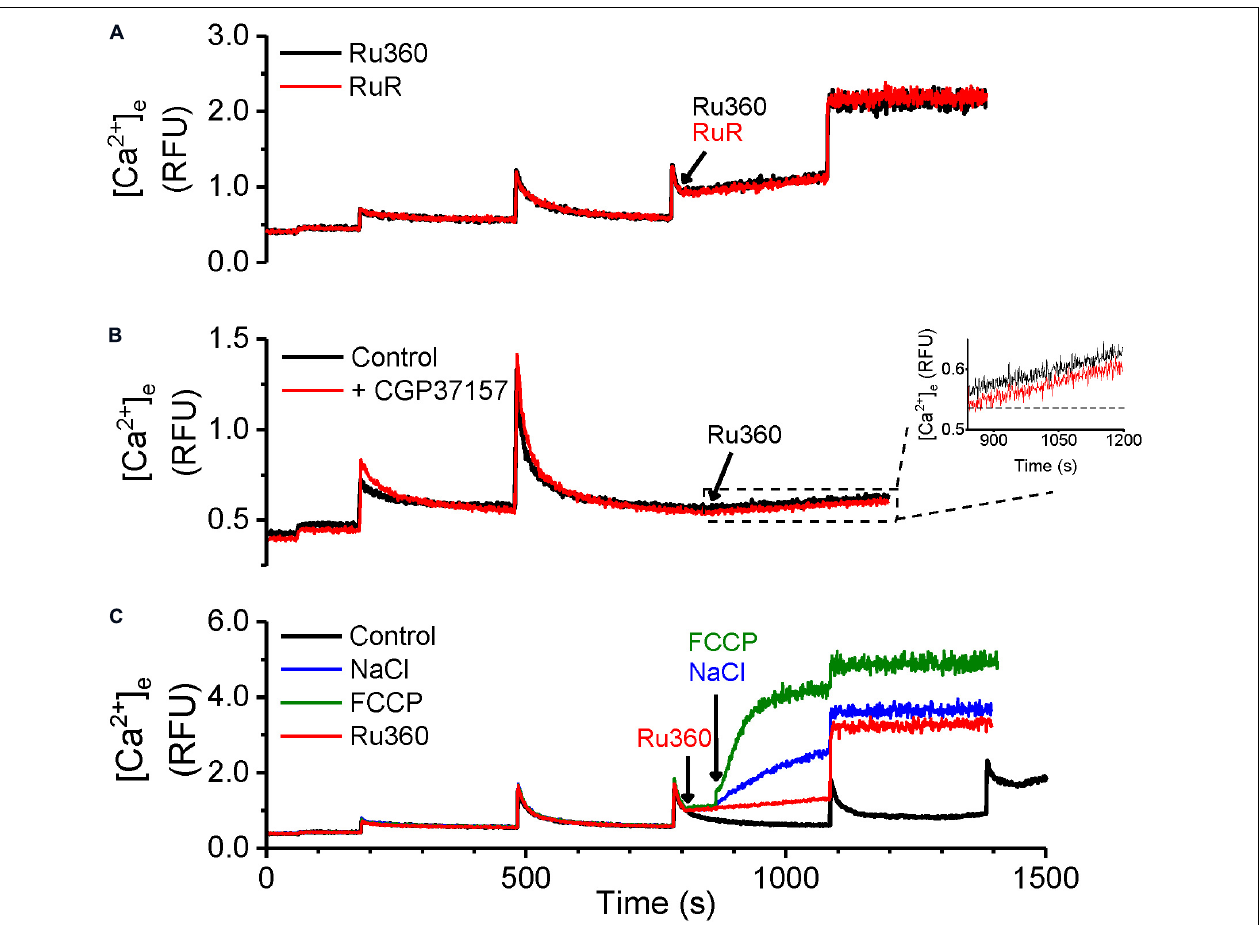
FIGURE 5 | Ca 2 + -efflux is not modulated by mitochondrial RyRs or NCLX. (A–C) Representative raw traces of extra-matrix Ca 2 + measured as relative fluorescence changes in Na + -free experimental buffer loaded with the Ca 2 + -sensitive ratiometric dye Fura-4F. (A) 20 µ M CaCl 2 pulses were given before and after addition of either 1 µ M Ru360 (black trace) or 1 µ M RuR, mRyR inhibitor Ruthenium Red (red trace). (B) 20 µ M CaCl 2 pulses were given at 180 and 480 s, followed by the addition of 1 µ M Ru360 at 840 s in the absence (black trace) or the presence of NCLX inhibitor, CGP37157 (1 µ M, red trace). Inset: Greater detail of traces enclosed by dashed box in (B) from t = 840 to 1200 s. (C) Control (black trace): 20 µ M CaCl 2 pulses were given at periodic intervals of 300 s until mPTP opening. Other traces: 20 µ M CaCl 2 pulses were given at 180, 480, and 780 s, followed by 1 µ M Ru360 at 800 s (red trace), with further addition of 5 mM NaCl (blue trace), or 4 µ M FCCP (green trace) at 820